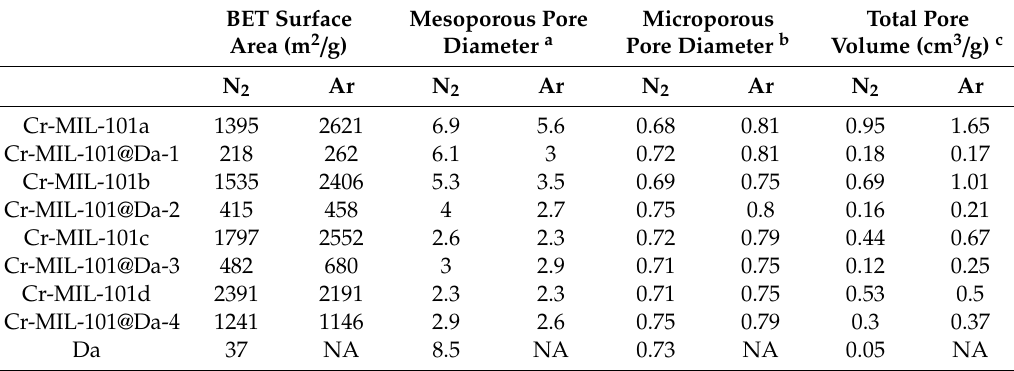
a —BJH desorption average pore diameter (4V / A), unit: nm. b —Horvath–Kawazoe median pore width, unit: nm. c —BJH adsorption cumulative volume of pores between 1.7 nm and 300.0 nm